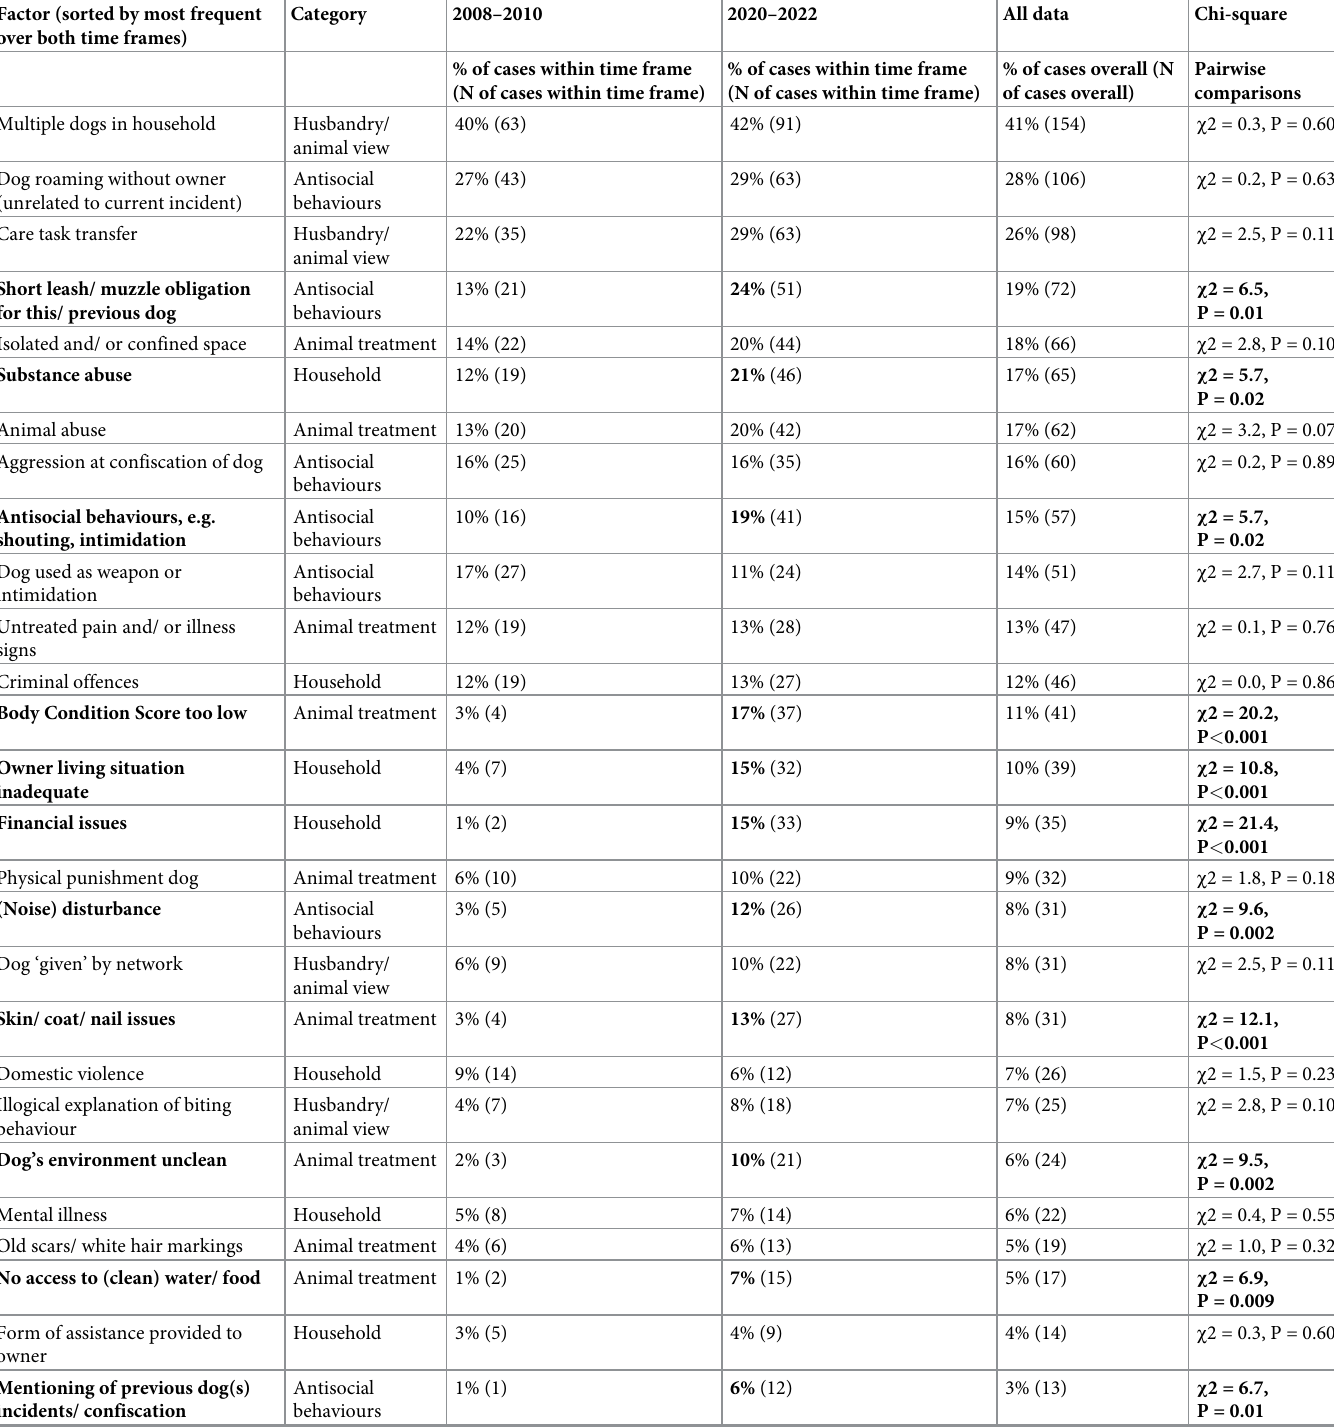
Table 9. Dog ownership factors applying to 374 cases of dogs confiscated for human-/ animal-directed biting incidents. We present percentages of cases (and counts between brackets) that a dog ownership factor was reported on, sorted from highest to lowest overall frequencies for 30 identified dog ownership factors for a first time frame (2008–2010), a second time frame (2020-mid-May 2022) and overall for both time frames. Pearson Chi-square values are indicated for the pairwise comparisons between the two time frames, per factor (P < 0.05, df = 1; significant differences in